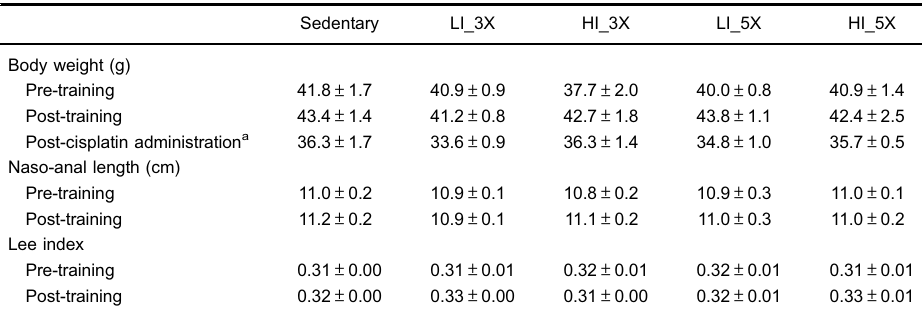
Table 1. Body weight, naso-anal length, and Lee index obtained before and after eight weeks of training.